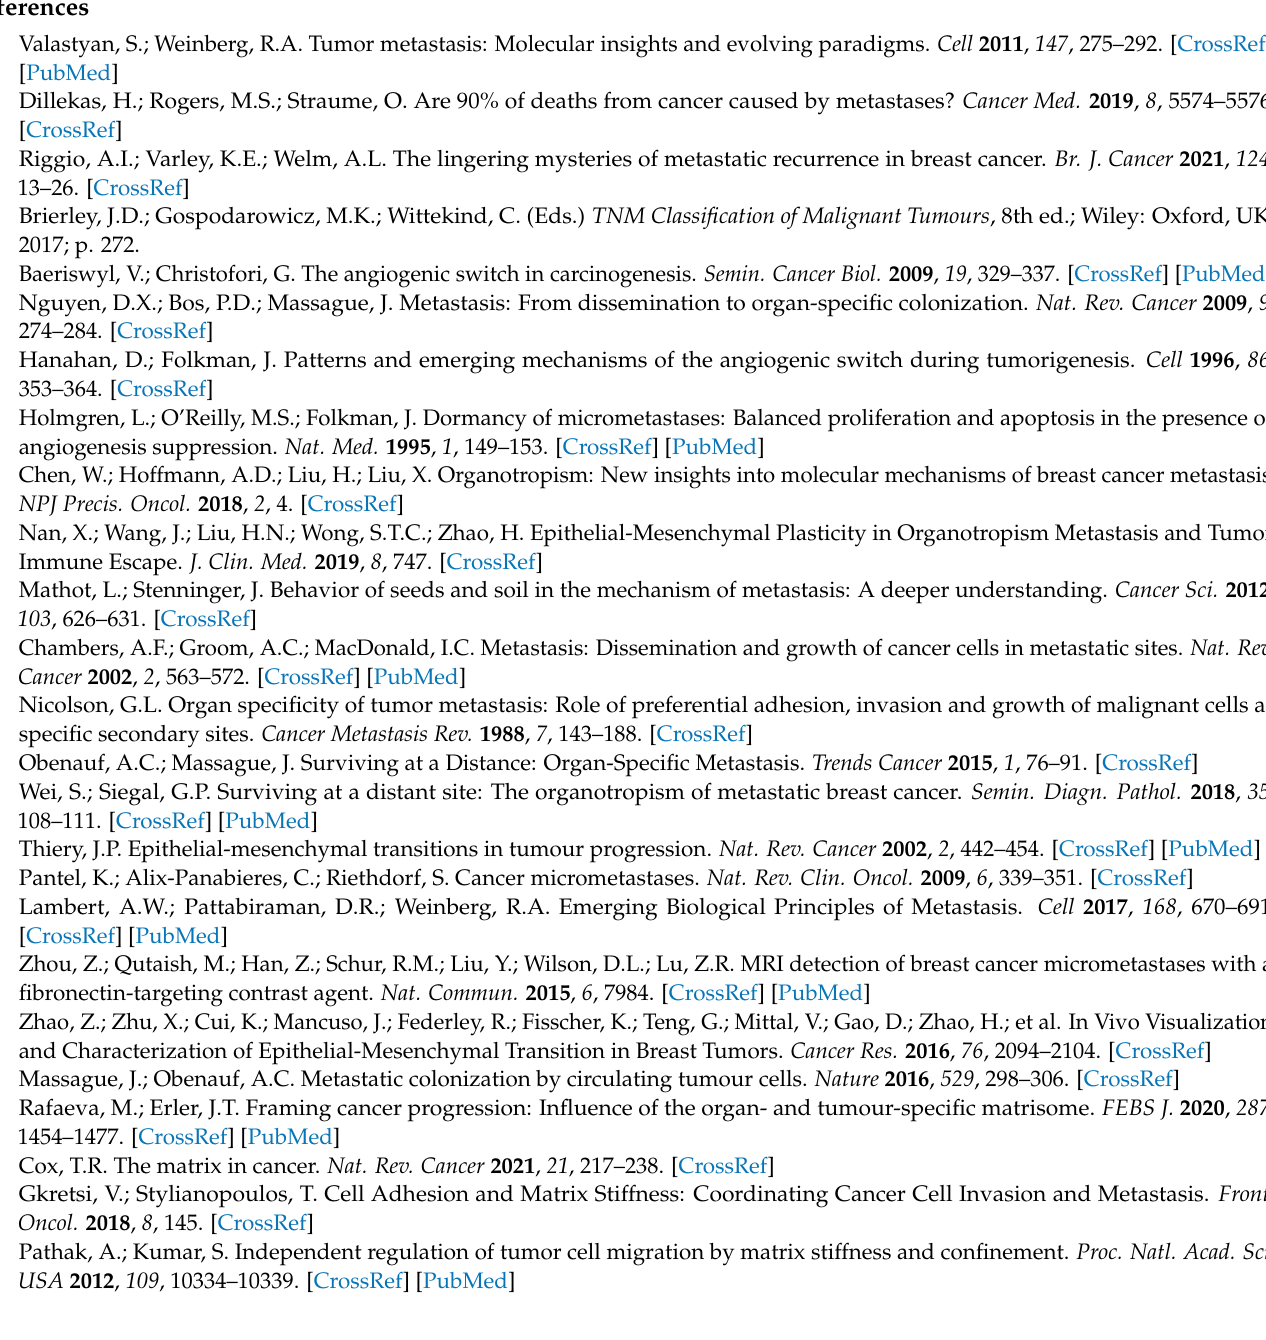
Figure A24. ( a ) Effect of iWO-DCL with an additional decalcination stage on CE tibial bone. ( b ) Recellularization of the bone AOSS with MDA-MB-231 cells. Staining with H&E, scale bars 100 µ